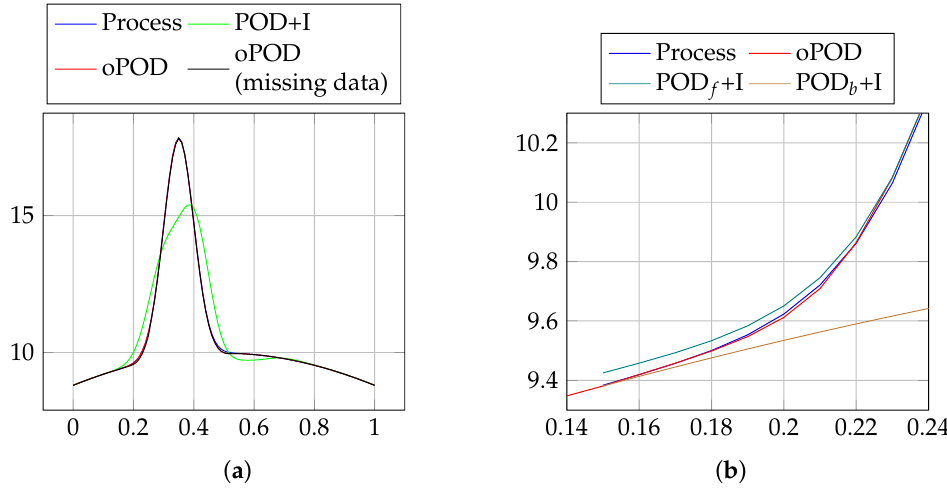
Figure 8. Process with POD+I and oPOD predictions for p = [ 25,0.35,ON ] . ( a ) Complete domain. ( b ) oPOD model interpolation.